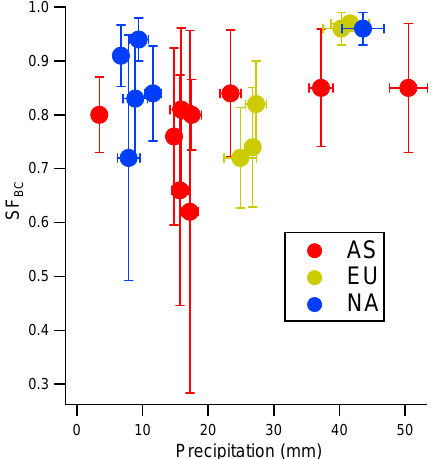
Figure 11. The calculated scavenged fraction of BC (SF BC ) vs. ac- cumulated precipitation, with the bars showing the ± propagated uncertainties for both precipitation and SF BC